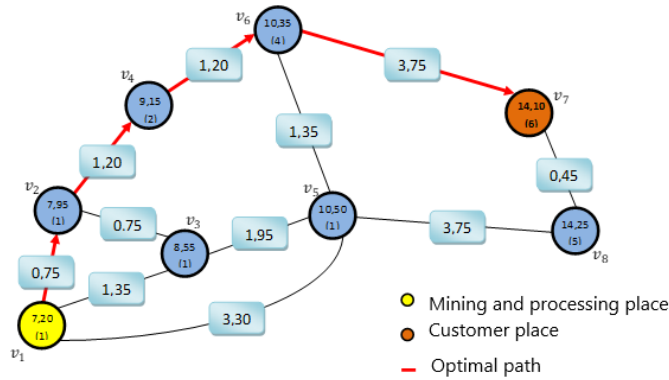
Figure 13. Optimal path from peaks 1 to 7.